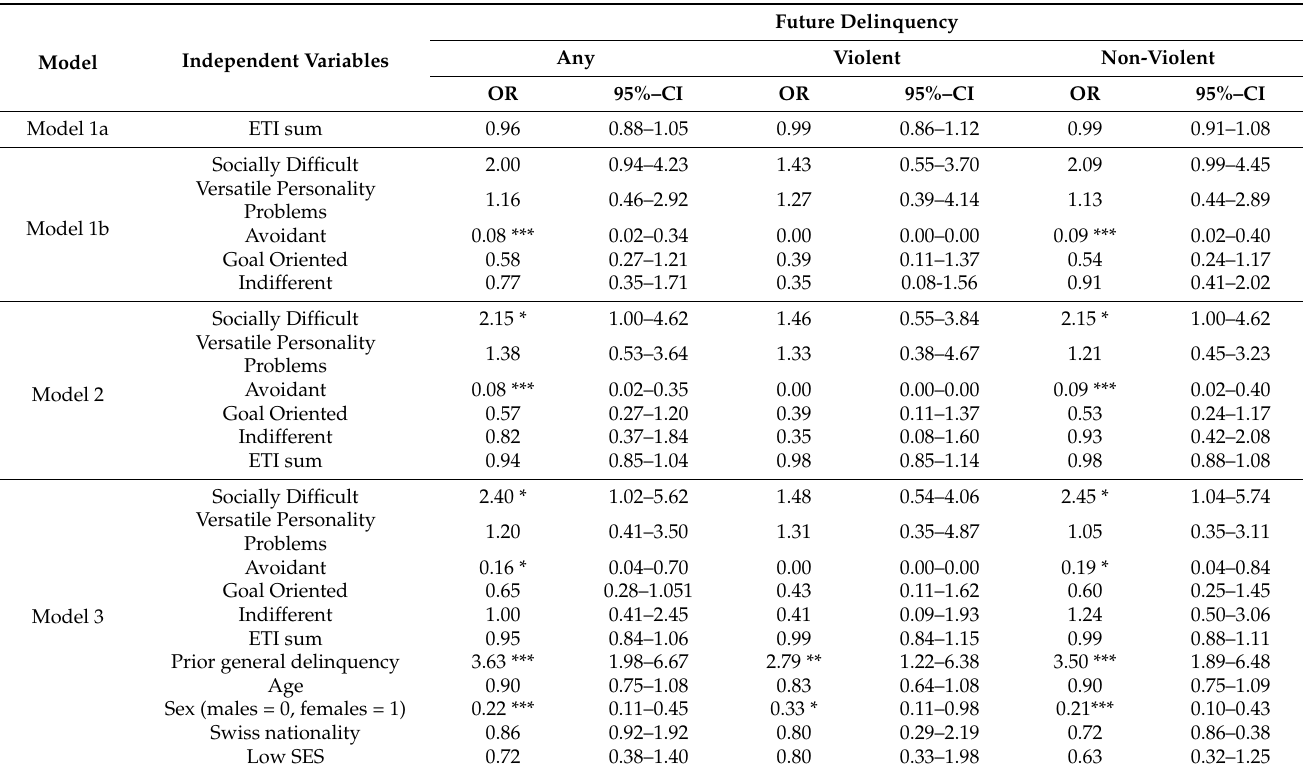
Table 3. Binary logistic regression analyses on future delinquency with ACEs, personality profiles, and covariates.